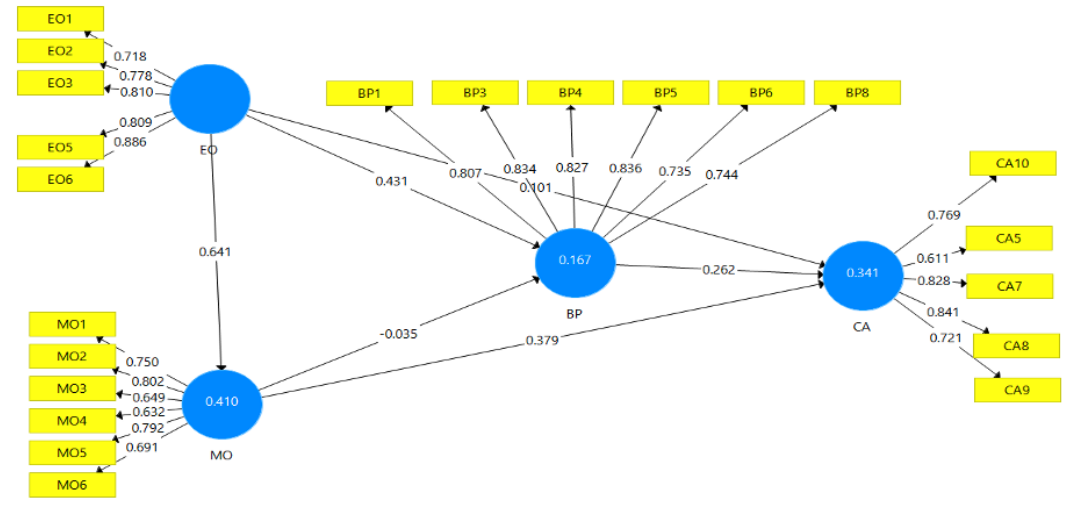
Figure 2: Structural Equation Model